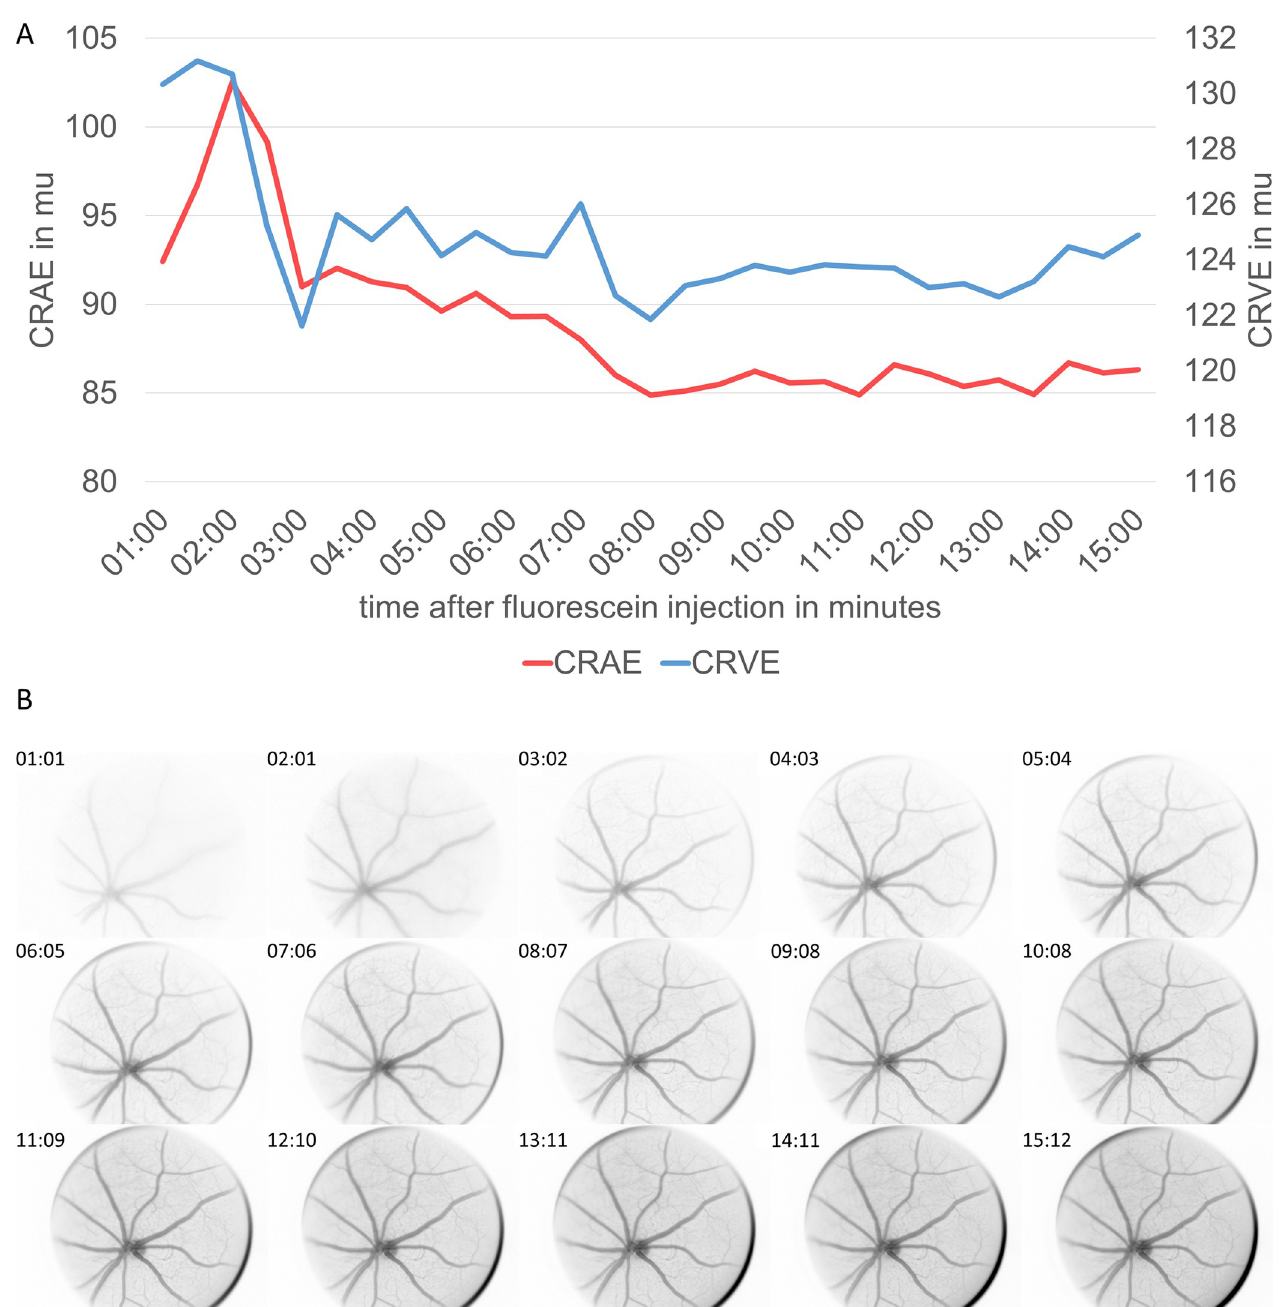
Fig 5. Time course after fluorescein injection. Time course of central retinal arteriolar (CRAE) and venular diameter equivalents (CRVE) after fluorescein injection in one mouse (A). CRAE and CRVE were averaged based on one image per timepoint analysed independently by two experienced investigators. Results are presented descriptively. Fundus images of one mouse every minute after fluorescein injection until 15 minutes after injection (B).